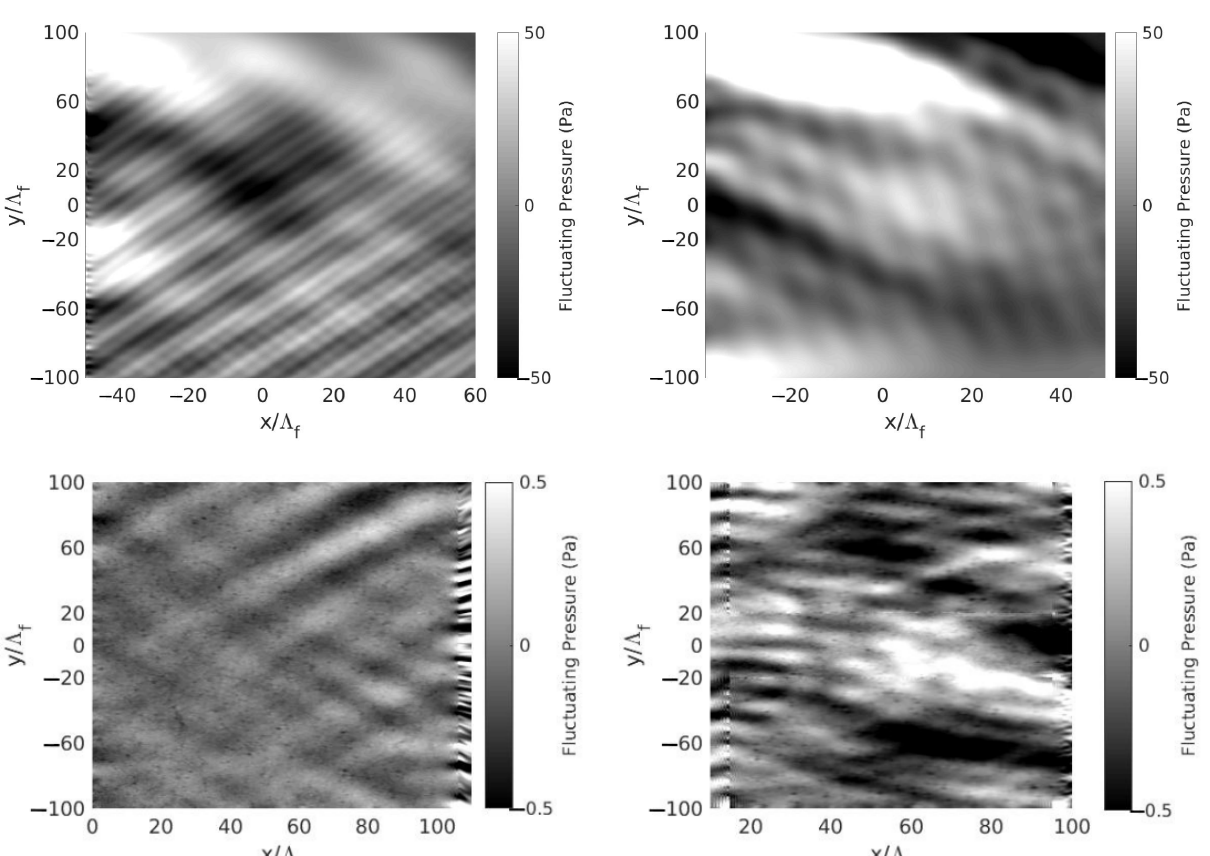
Figure 7. Fluctuating pressure field at the last iteration. Left column: Single Grid configuration. Right column: Multi Grids configuration. Top plots: RFM simulations. Bottom plots: RFM-P3D simulations. The pressure is shown between − 50 and 50 Pa for the RFM simulations, while it is shown between − 0.5 and 0.5 Pa for the RFM-P3D